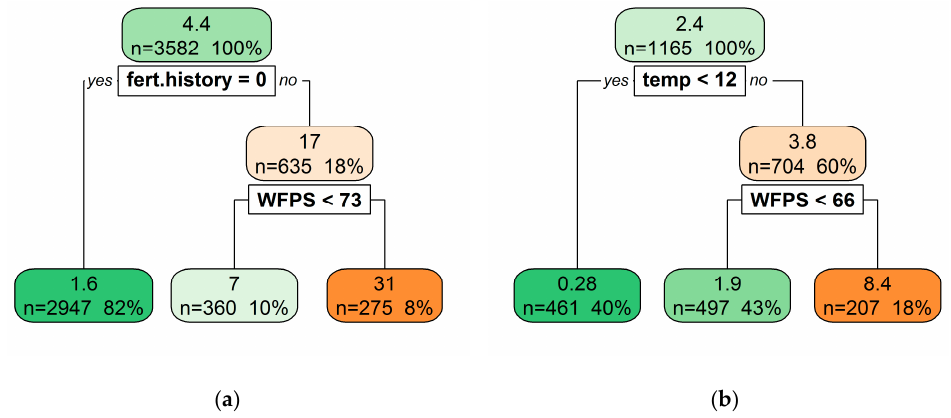
Figure 6. Decision tree classifying daily N 2 O emissions according to soil conditions (soil temperature and WFPS) and fertilization history (fert.history = 0 if there was no fertilization event during the last 70 days) for: ( a ) perennial crops; and ( b ) semi-perennial crops. The number at the top of each colored box corresponds to the mean daily N 2 O flux in the class (in g N 2 O-N ha − 1 day − 1 ). The number of observations in each class (n) is also indicated, as well as the proportion of the total number of observations in each class. Color intensity is proportional to mean N 2 O flux in the class (from green for the lowest fluxes to orange for the highest fluxes). Below the colored box is the key variable and the condition used for partition into two classes: the one on the left for when the condition is met, the one on the right for when it is not met.